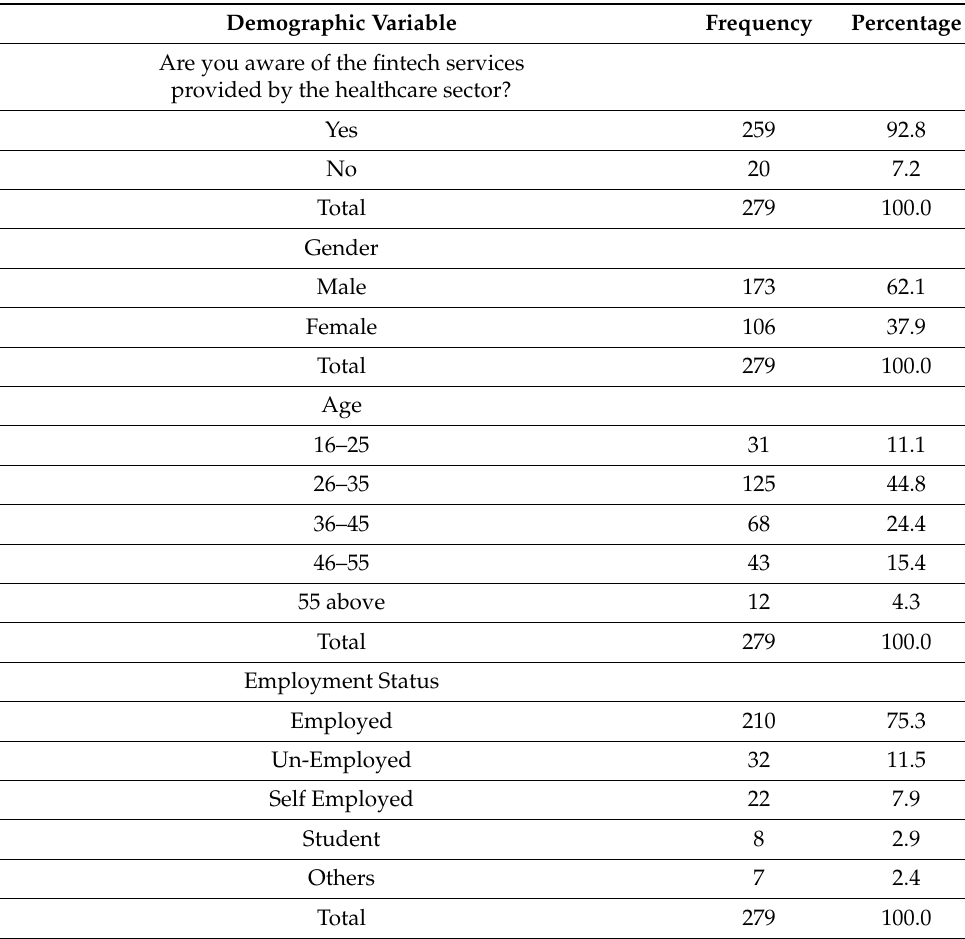
Table 1. Demographic profile of the